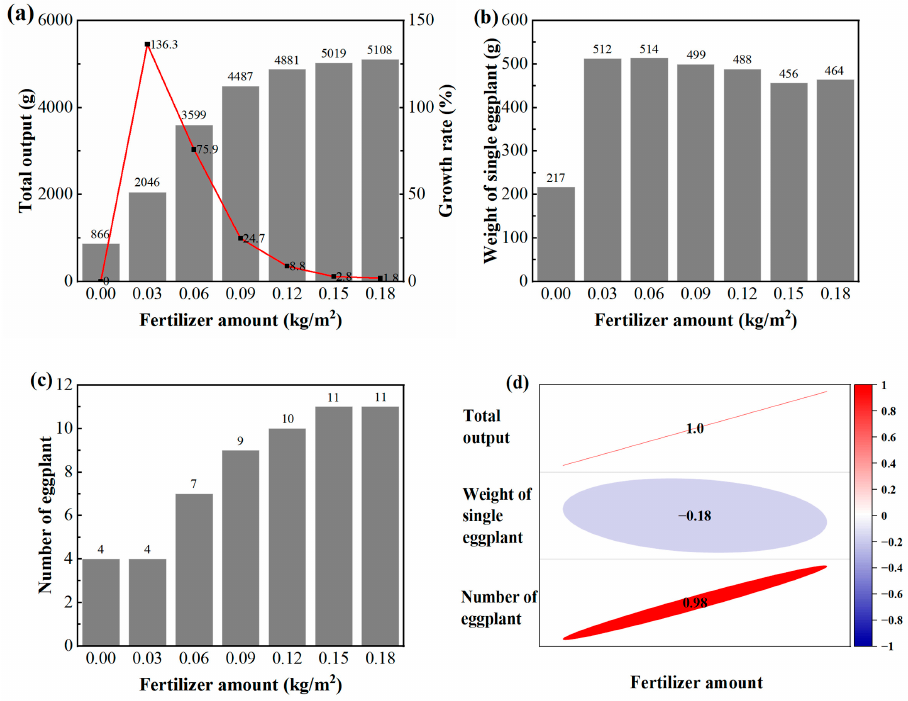
Figure 4. Relationship between fertilizer amount and total output, the weight of single eggplant, number of eggplants, and the correlation between them and fertilizer amount.